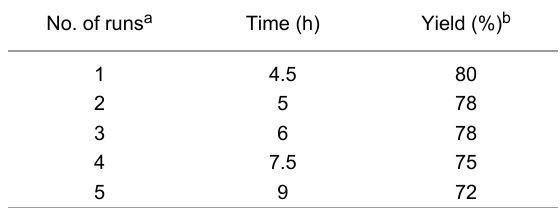
Table 3: Recyclability of HAP–Cs 2 CO 3 as demonstrated for 4-meth- oxybenzaldehyde and malonic acid in water at 80